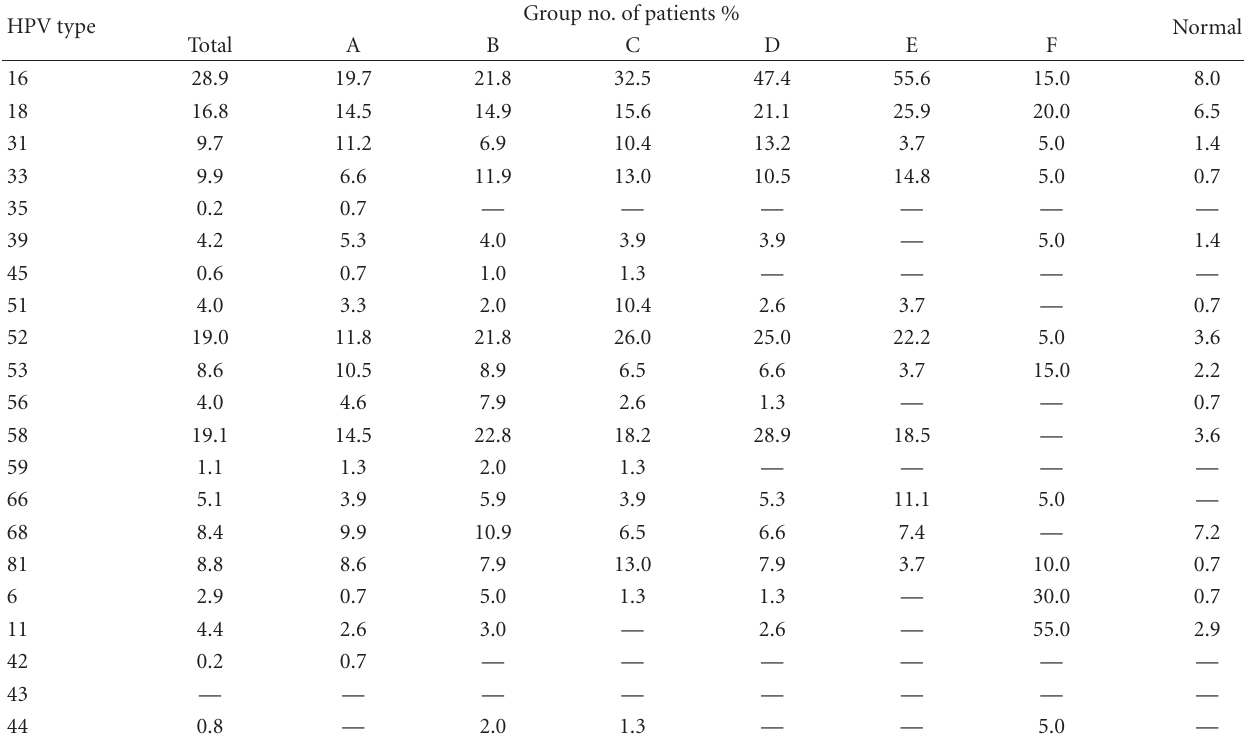
Table 3: Positive rates of di ff erent HPV genotypes in each group detected by HybriMax. Group no. of patients % HPV type